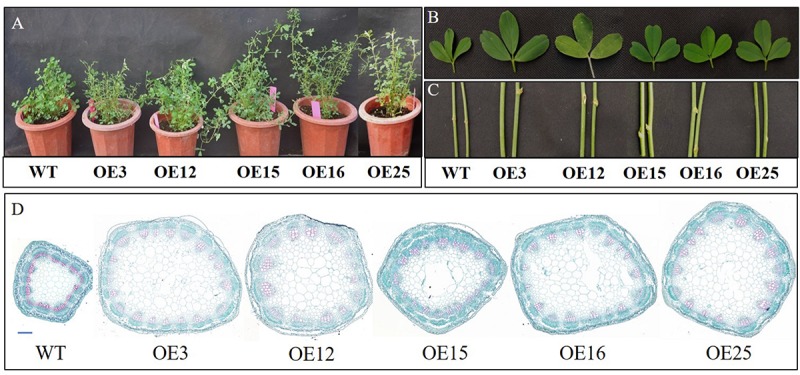
Effects of MsASMT1 overexpression on alfalfa growth and development. (A) Growth situation of WT plants and OE-MsASMT1 transgenic plants after growing in greenhouse for two months; (B,C) the leaf (B) and stem (C) comparison between WT plants and several OE-MsASMT1 transgenic plants, scale bar, 1 cm; (D) Stem cross sections with safranin green staining of WT plants and OE-MsASMT1 transgenic plants, scale bar, 1 mm.